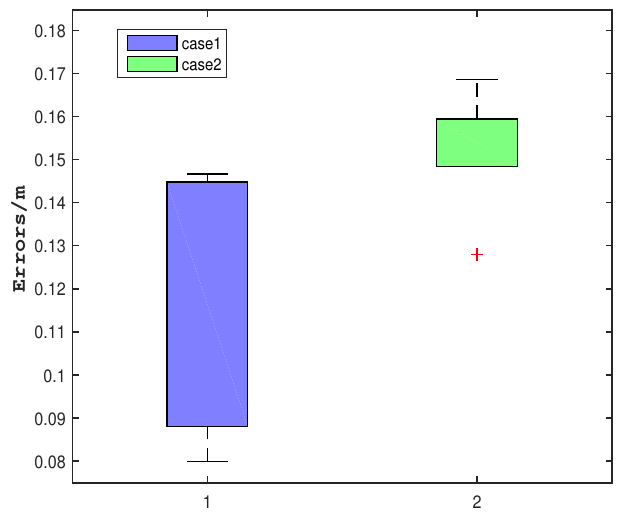
Figure 5. The average localization errors.